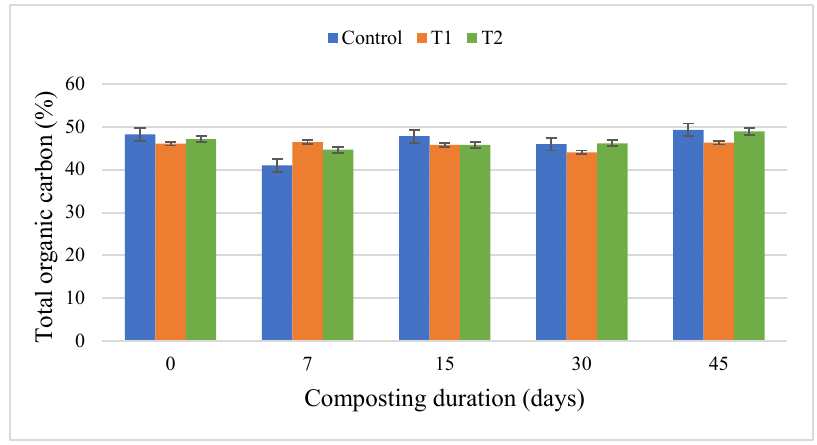
Figure 7. TOC level changes in control, T1, and T2 samples at 0, 7, 15, 30, and 45 days.